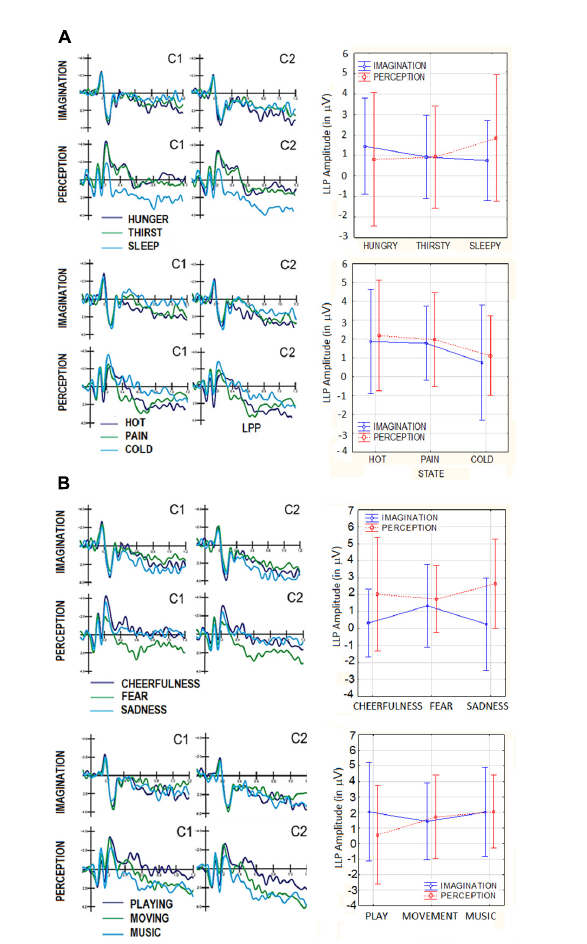
FIGURE5 (A) Grand-average ERP waveforms recorded at central and posterior scalp sites in the perceptual and imaginative conditions, as a function of motivational states. top = primary needs; bottom = somatosensory sensations: (B) grand-average ERP waveforms recorded at central and posterior scalp sites in the perceptual and imaginative conditions, as a function of motivational states. Top = affective states; bottom = secondary